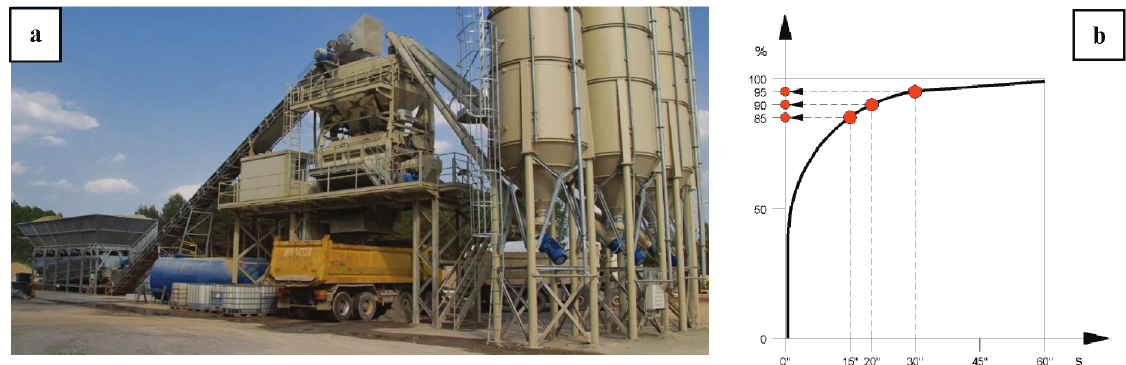
Fig. 5. Concrete plant for the purposes of extending the Katowice-Pyrzowice airport (a) [17], and (b) interdependence of mix homogenisation in %, on the mixing time in seconds, in two-shaft mixers MB